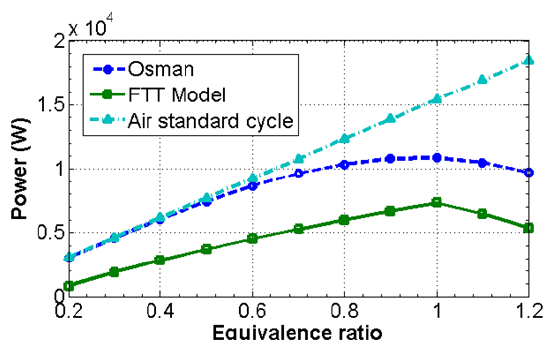
Figure 7. Variation of power with the fuel-air equivalence ratio and engine speed using various models.